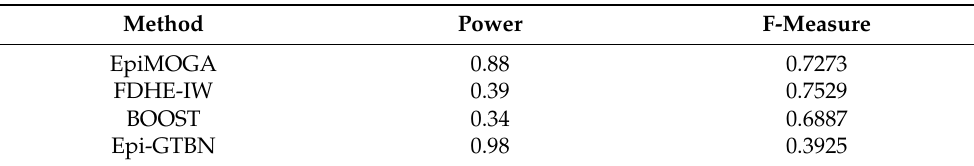
Table 2. Two index values of EpiMOGA, FDHE-IW, BOOST and Epi-GTBN (MAF = 0.2, sample size = 600).